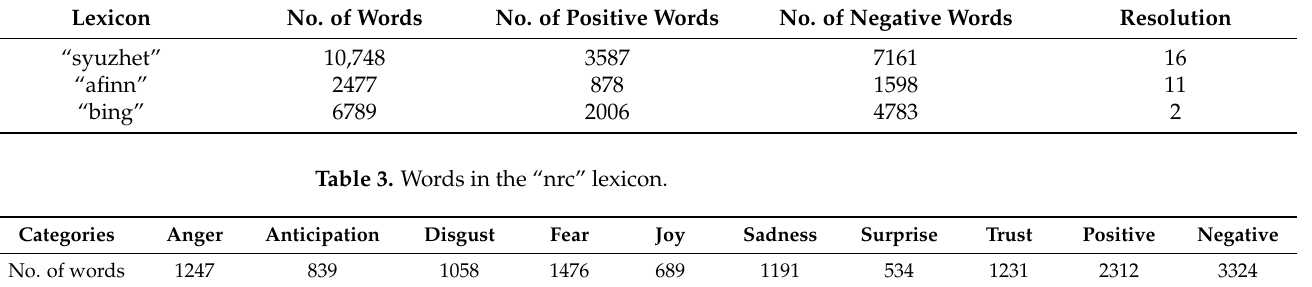
Table 2. Details about the “syuzhet”, “afinn”, and “bing” lexicons.